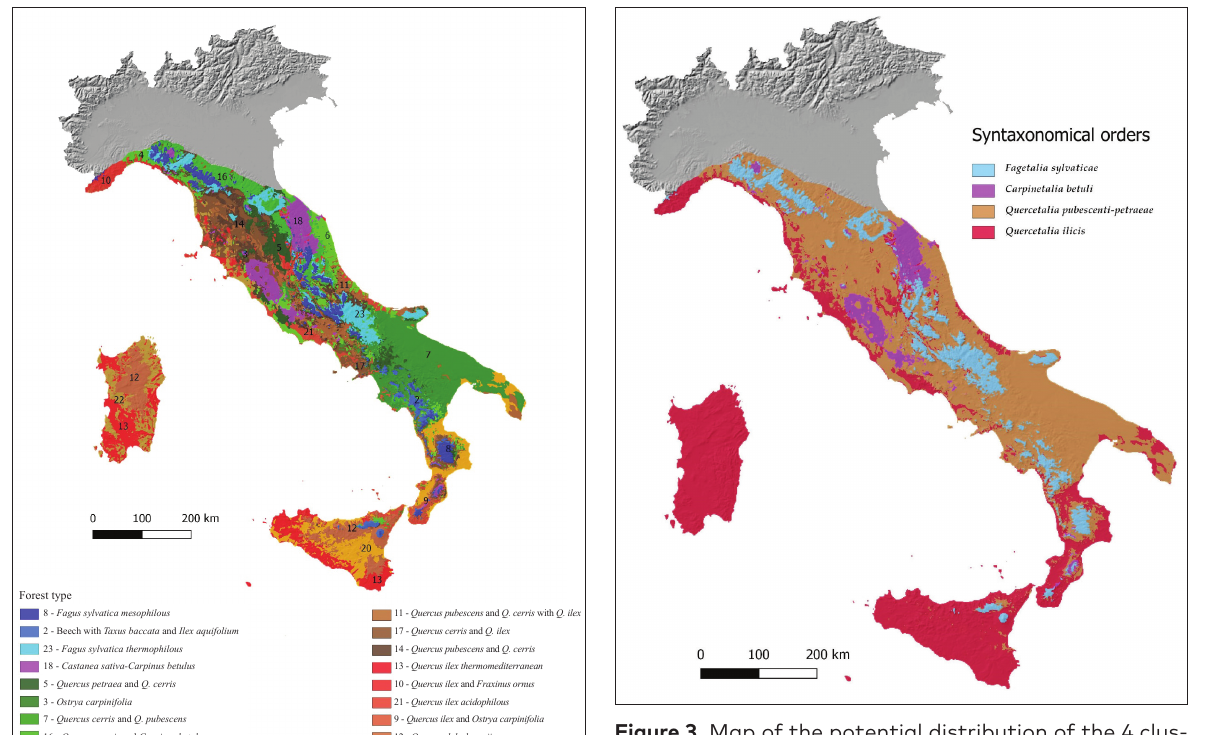
Figure 3. Map of the potential distribution of the 4 clus- ters corresponding to main syntaxonomic forest orders recognized for Italy: A – Fagetalia sylvaticae , B – Carpin- etalia betuli , C – Quercetalia pubescenti-petraeae , D – Quercetalia ilicis